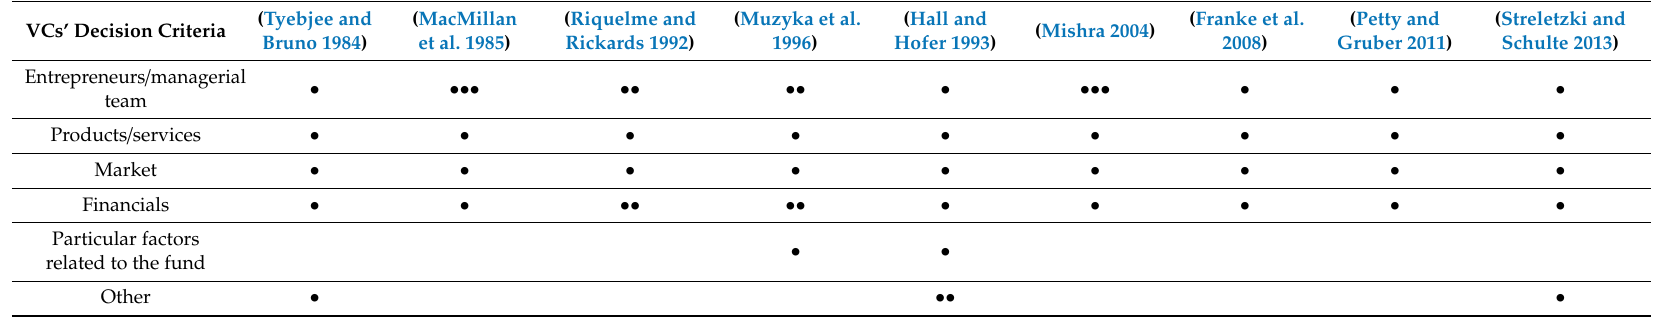
Table 1. Major Venture Capitalists’ (VCs’)decision criteria in selected international studies.